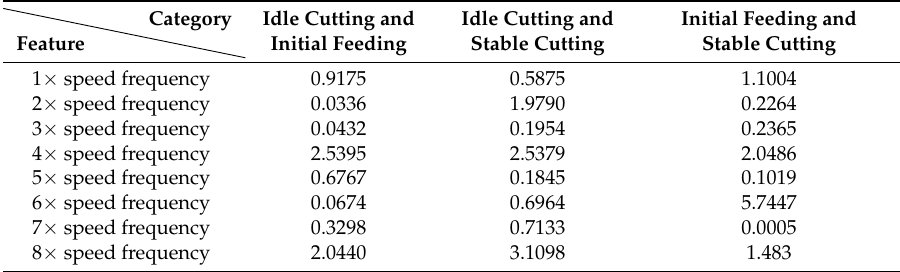
Table 1. Fisher scores (FS) results (using frequency domain features as an example).